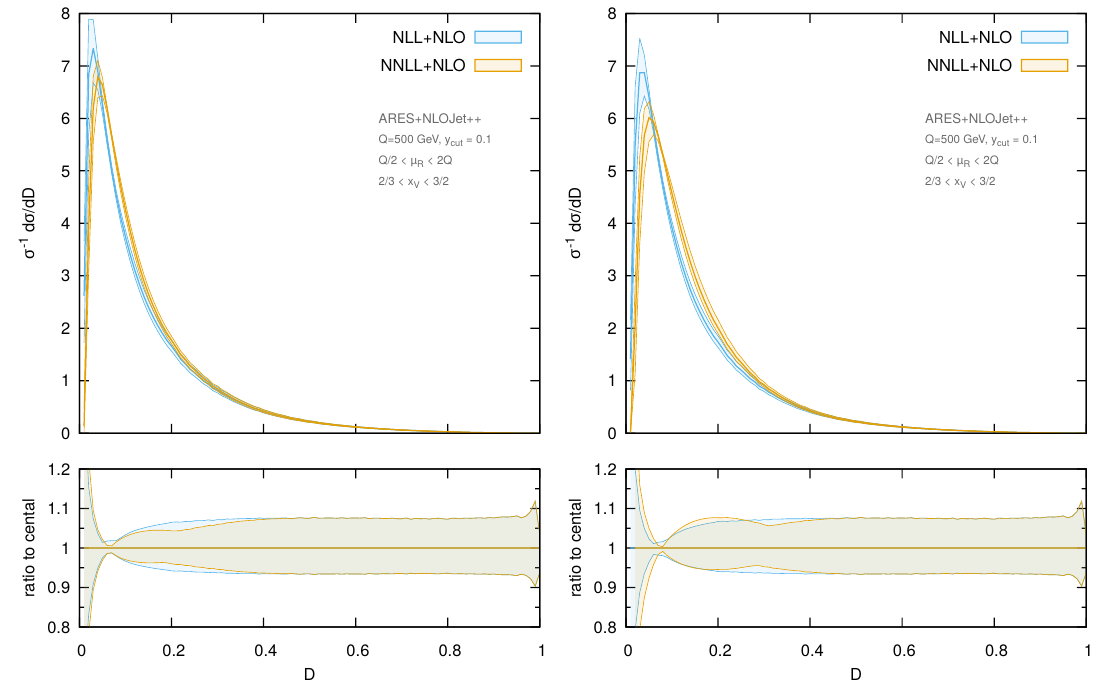
Figure 6 . The matched distribution for y cut = 0 : 1 and Q = 500GeV. The left plot using the X const scheme and the right using the X prod